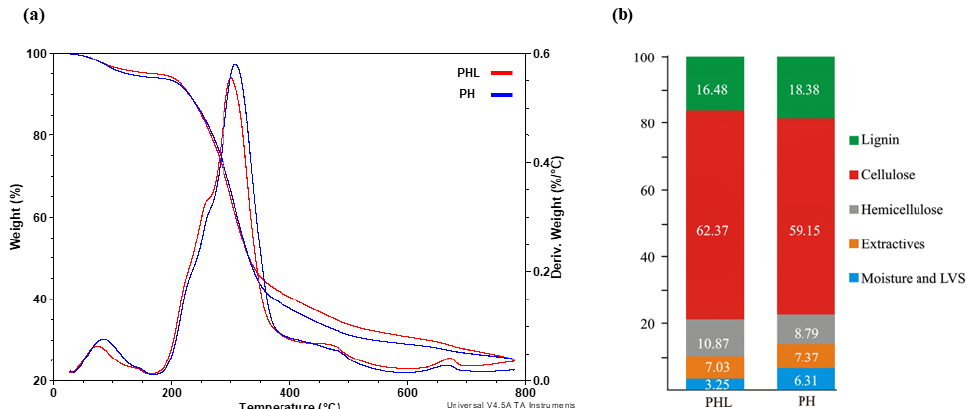
Figure 1. The TGA and DTG curves ( a ) of PHL and PH samples, the deconvolution of DTG curves ( b ); LVS–light volatile species.